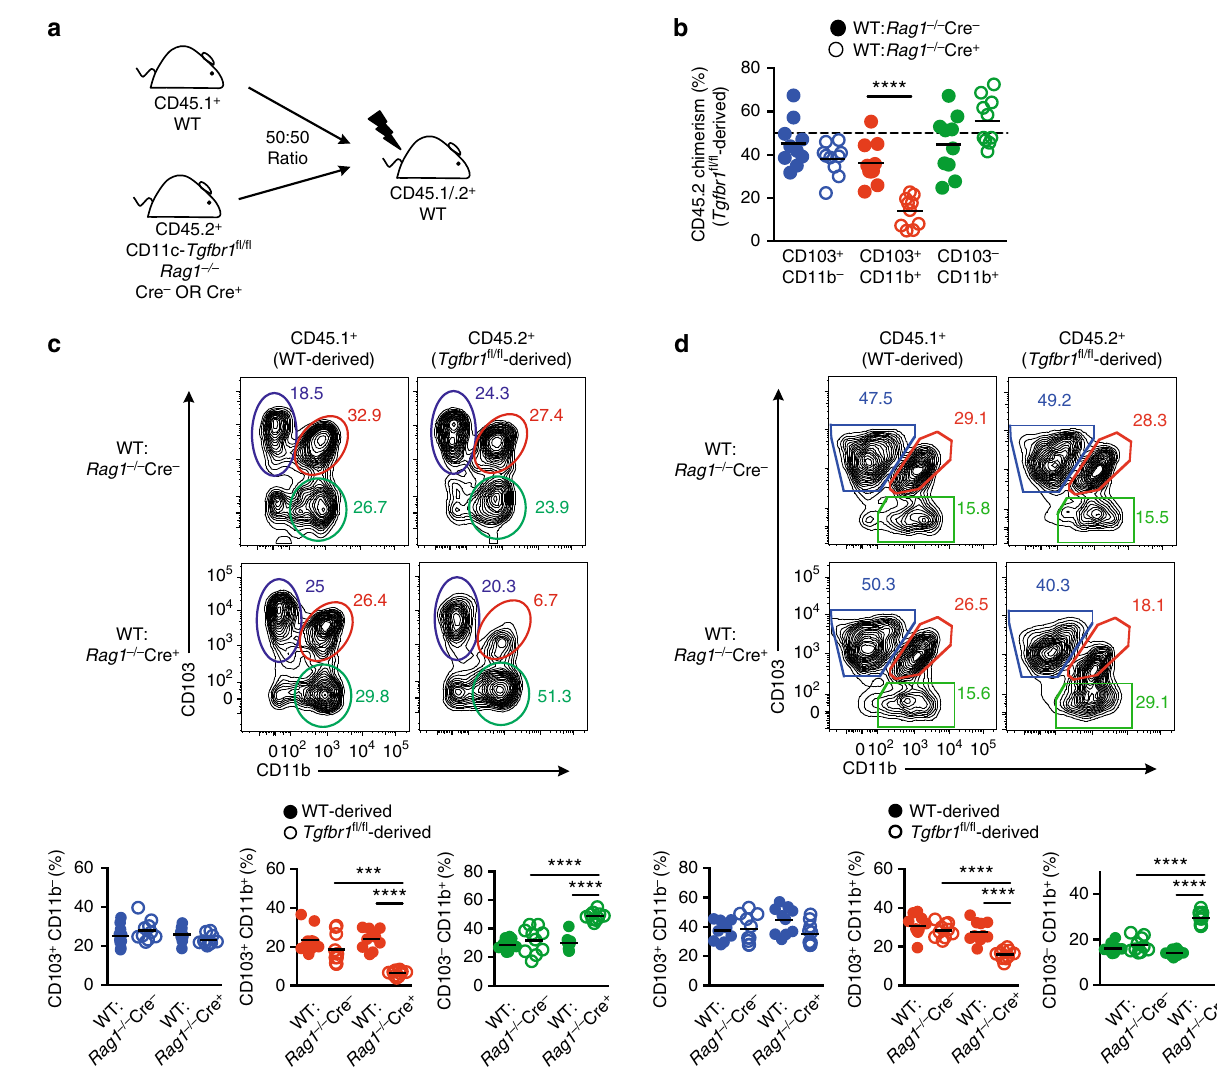
Fig. 4 TGF β R1-mediated control of DC homeostasis is cell intrinsic. a Experimental scheme for generation of mixed BM chimeric mice by reconstitution of irradiated CD45.1 + × CD45.2 + mice with a 1 : 1 mixture of BM from CD45.1 + WT and Rag1 − / − Cre − or Rag1 − / − Cre + CD45.2 + donors. b CD45.2 + Tgfbr1 fl / fl - derived chimerism among DC subsets from WT: Rag1 − / − Cre − or WT: Rag1 − / − Cre + mixed BM chimeras 8 – 12 weeks post reconstitution. Data are pooled from two independent experiments with a total of 10 mice per group and dotted line represents input chimerism. **** p < 0.0001 determined by Student ’ s t -test followed by Holm – Sidak correction. c , d Representative expression of CD103 and CD11b by CD45.1 + (WT-derived) or CD45.2 + ( Tgfbr1 fl / fl -derived) CD11c + MHCII + CD64 − cells from the SILP c or MLN d of WT: Rag1 − / − Cre − or WT: Rag1 − / − Cre + mixed BM chimeras 8 – 12 weeks post reconstitution. Scatter plots show the frequency of each DC subset of the total DC pool derived from each BM source. Data are pooled from two independent experiments with 10 mice per group. Each symbol represents an individual animal and the horizontal bar represents the mean. *** p < 0.001 and **** p < 0.0001 using one-way ANOVA followed by Bonferroni ’ s multiple comparisons